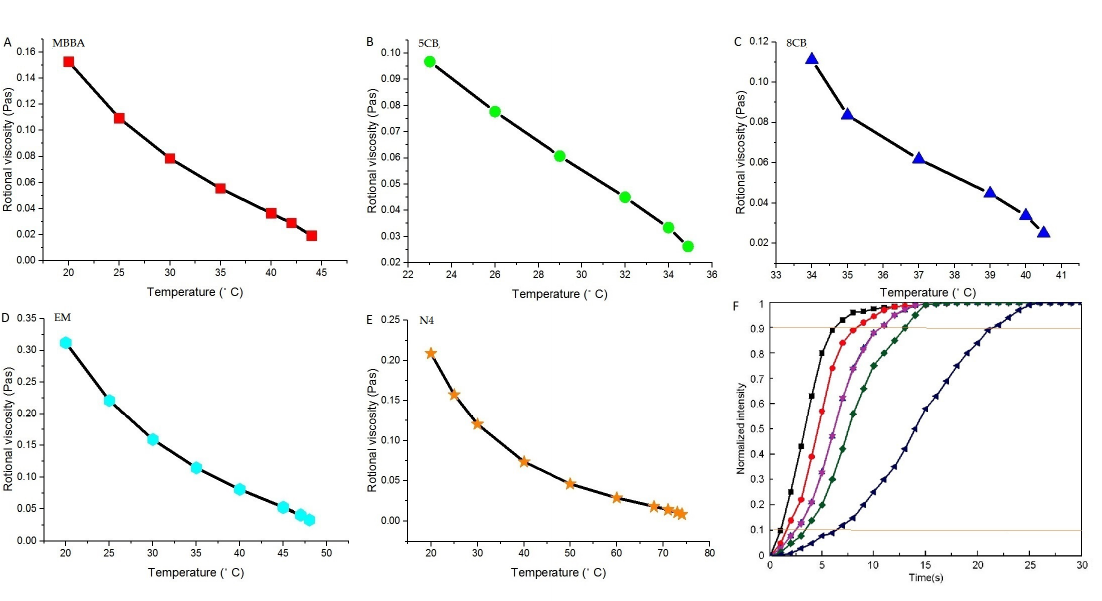
Figure 2. ( A )–( E ) Rotational viscosity as the function of the operational temperature for the five di ff erent kinds of LCs respectively (MBBA, 5CB, 8CB, EM and N4) ( F ) Normalized intensity as the function of the polarized blue light exposing time (two parallel orange lines marked the definition of the response time for the